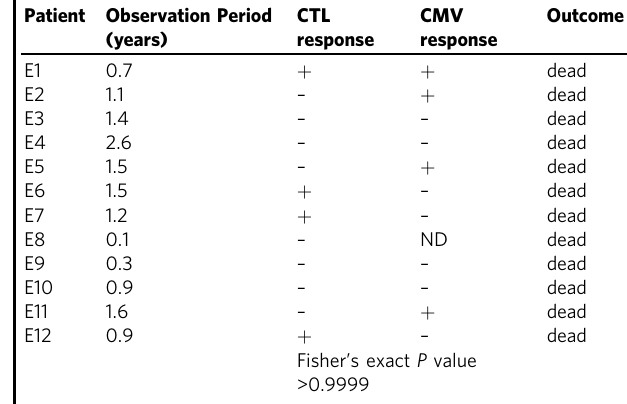
Table 5 Individual survival data of the MRP3 peptide vaccine